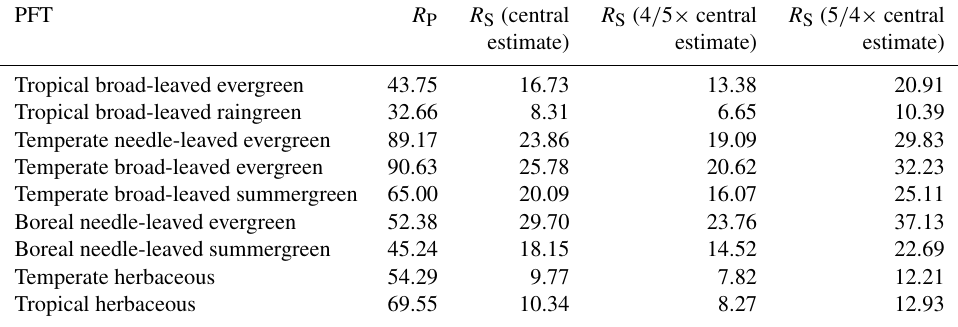
Table 2. Prescribed C:N ratios for plant production ( R P ) and soil organic matter ( R S ) (McGuire et al., 1992; Xu-Ri and Prentice, 2008). PFT R P estimate) estimate) estimate) Tropical broad-leaved